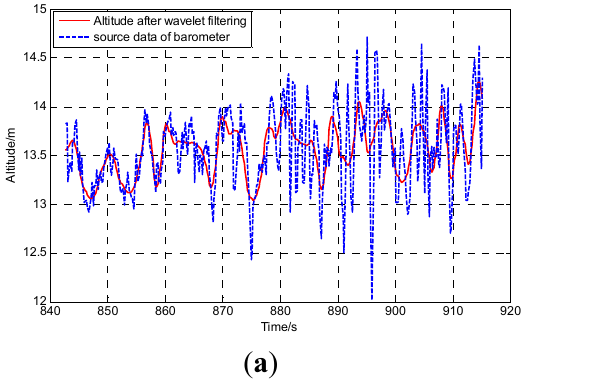
Figure 3. ( a ) The comparison between the original barometer data and the wavelet filtered data. ( b ) The comparison between the original DGPS data and the wavelet filtered